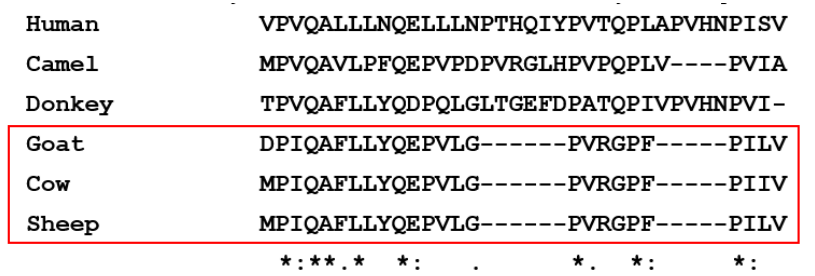
Figure 1. Sequence alignment of β -casein region MPIQAFLLYQEPVLGPVRGPFPII from the bovine, donkey, human, goat, and sheep milk. Sequences were obtained through the CLUSTAL multiple sequence alignments by MUSCLE (3.8) at https://www.ebi.ac.uk/Tools/services/web_muscle/ toolform.ebi, accessed on 1 December 2021. The asterisk (*) indicates the amino acids that are conserved between sequences.